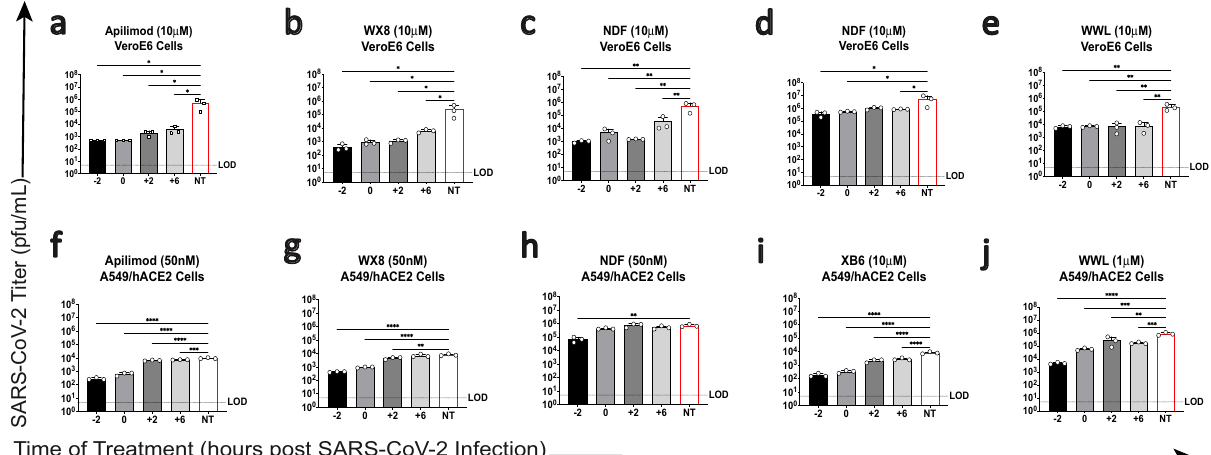
Fig. 1 Time of addition analysis for PIKfyve inhibitor treatment in vitro. Time of addition analysis was performed by administering treatment either 2 h pre-infection, at the time of infection, or 2- or 6-h post-infection with SARS-CoV-2 in ( a – e ) VeroE6 cells or ( f – j ) A549/hACE2 cells. Supernatant titers at 24 h post infection are shown for a , f Apilimod, b , g WX8, c , h NDF, d , i XB6, and e , j WWL as compared to independent, no treatment controls. Ordinary one-way ANOVA analysis was used to compare differences in supernatant viral titer between treated cells and the no treatment control (red); * p ≤ 0.1, ** p ≤ 0.01, *** p ≤ 0.001, **** p ≤ 0.0001. NT, no treatment; LOD: limit of